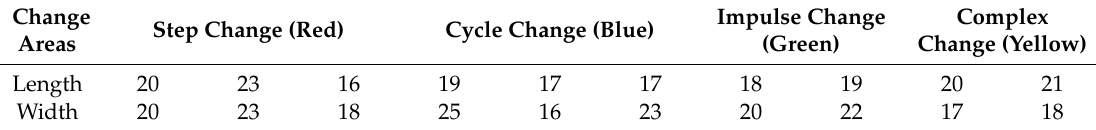
Figure 5. The synthetic time-series synthetic aperture radar (SAR) dataset (6 1-Look images): ( a ) The base map of an approximately noise-free image; ( b ) Ground truth of manually set changes; ( c ) Example of four change patterns (black: no change, red: step change, green: impulse change, blue: cycle change and yellow: complex change). Table 2. The size of 10 change